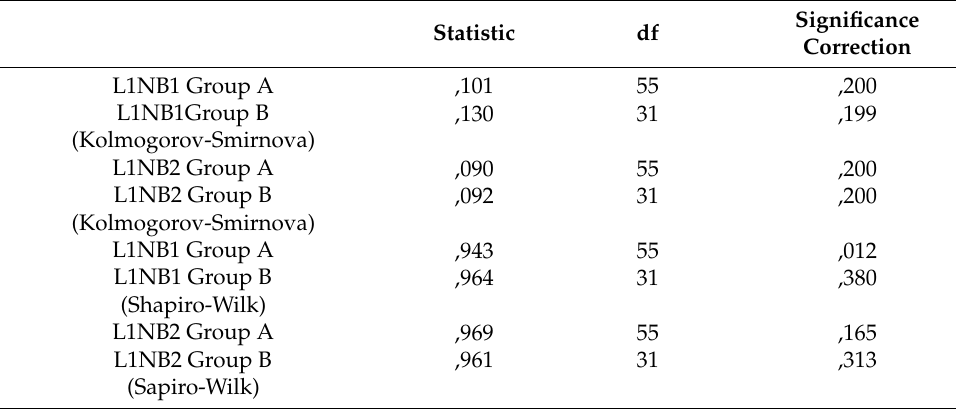
The overjet represents the horizontal distance between the upper and the lower dental arch and their comparison before and after the treatment in group A with clear aligners. OJ1 represents the initial overjet while OJ2 is the after-treatment overjet as shown in Table 3. Similar results were shown in Group B (control) when the mean value OJ1 was 4.08 mm versus 3.33 mm. The parameters concerning the gonial angle and the relationship of the skeletal bite were not